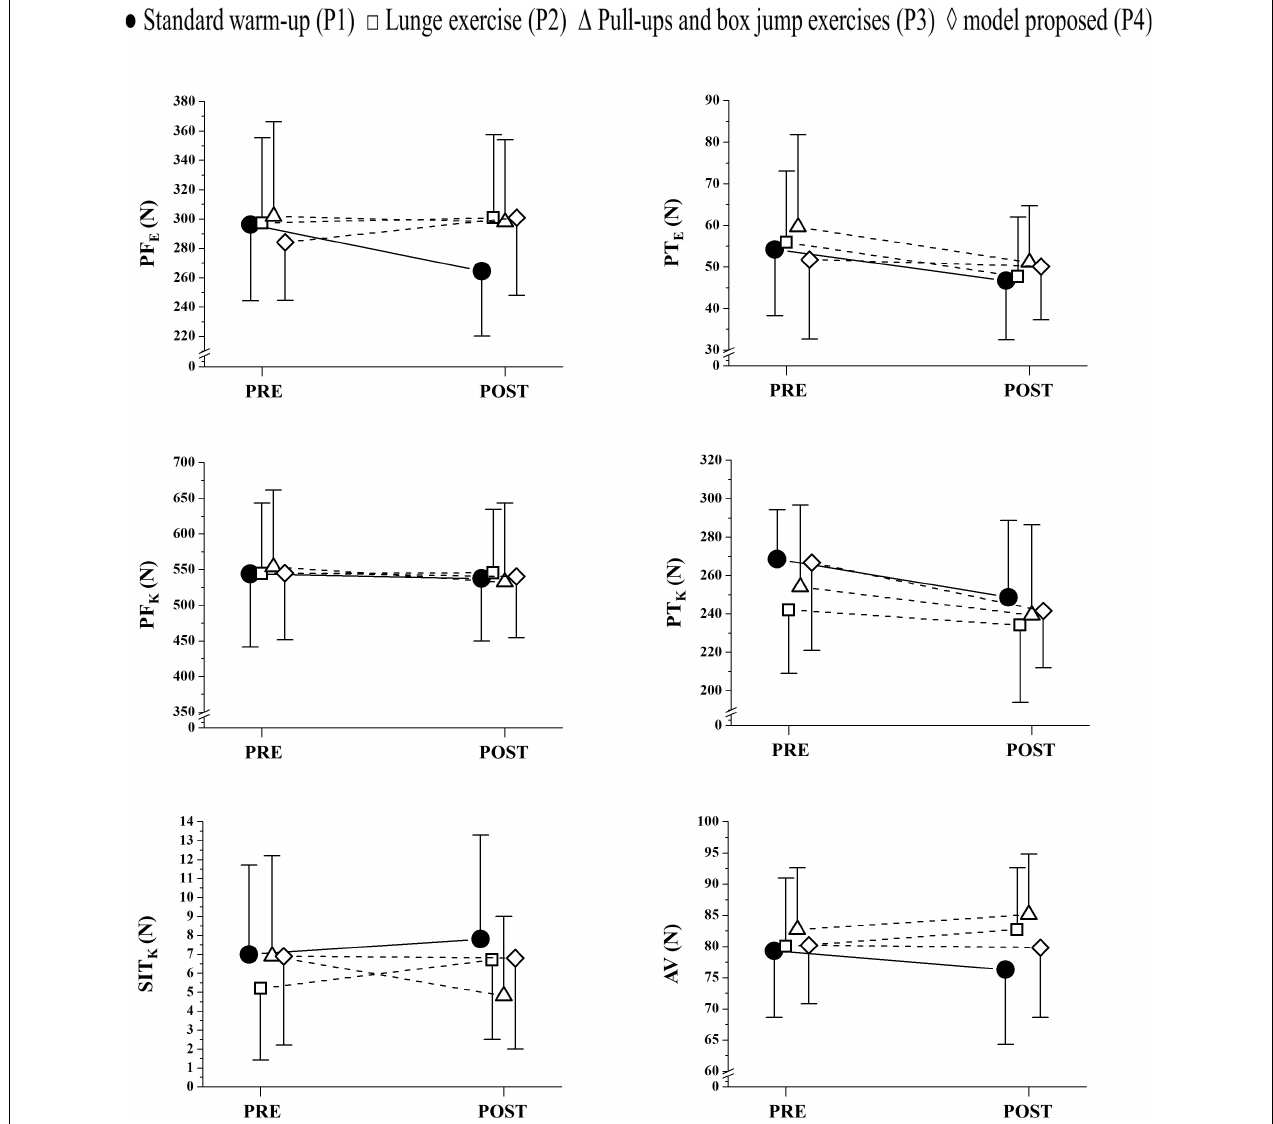
FIGURE 3 | Mean ± standard deviation of the variables obtained in the elbow and knee extension musculature before and after the effort of 50-m. PF E : Peak Force of elbow extension musculature; PT E : Peak Twitch of elbow extension musculature; PF K : Peak Force of knee extension musculature; PT K : Peak Twitch of knee extension musculature; SIT K : Superimposed Twitch of knee extension musculature; VA: Voluntary